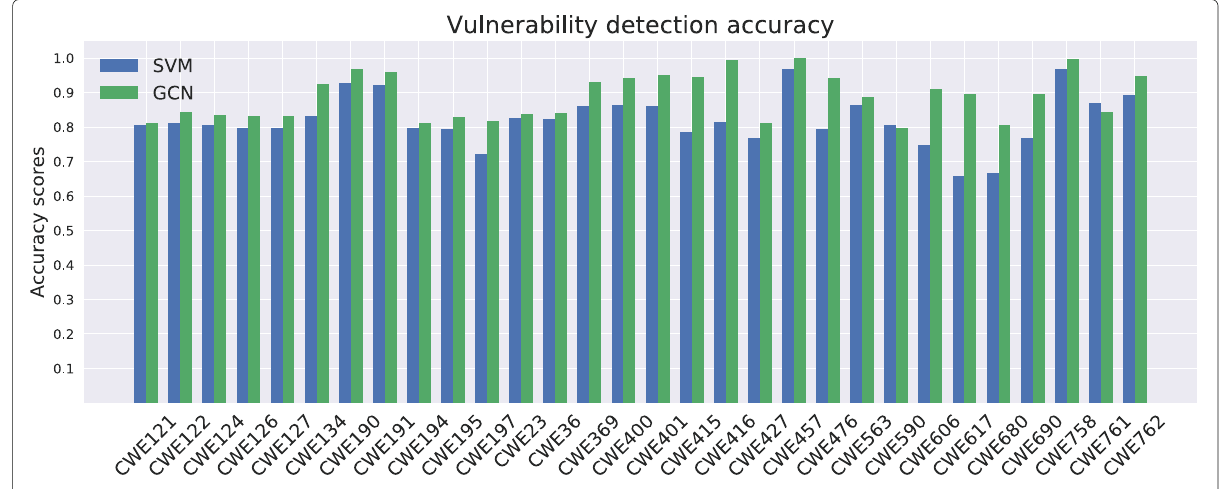
Fig. 6 Experimental results for vulnerability discovery on the Juliet test suite